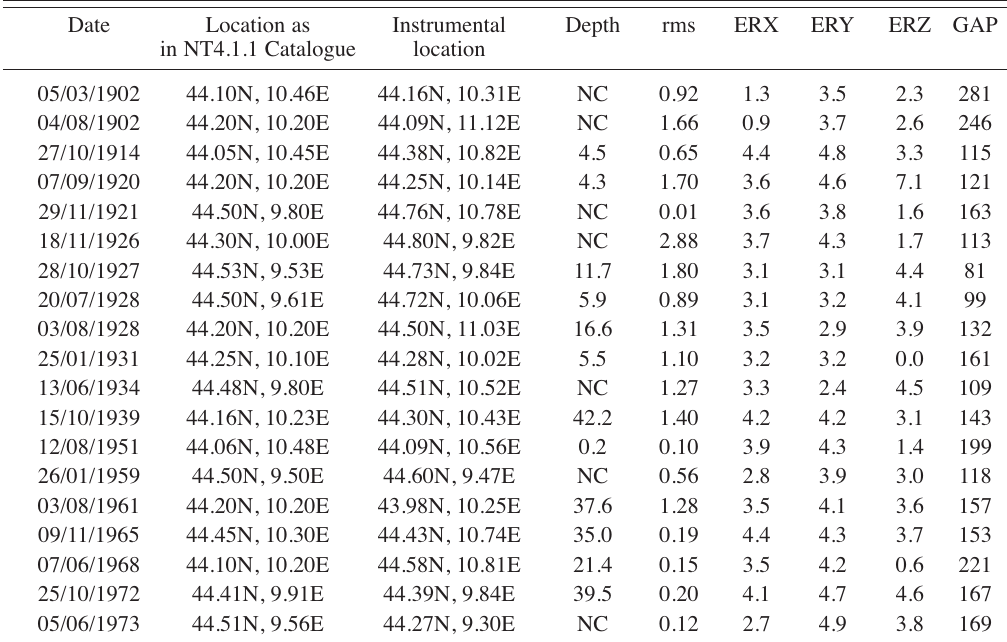
Table II. Index of the events relocated in this work. The list is the final result of a selection done in the area 43.6-44.6 and 9.1-10.5 after checking for multiplicity of data sources and minimum number of phase pickings (see text). The locations parameters of the second column are those of the NT4.1.1 (Camassi and Stucchi, 1997) Catalogue. The remaining columns are relative to instrumental locations and report the position, the depth and the errors associated to the locations. NC is used for depths that are not adequately